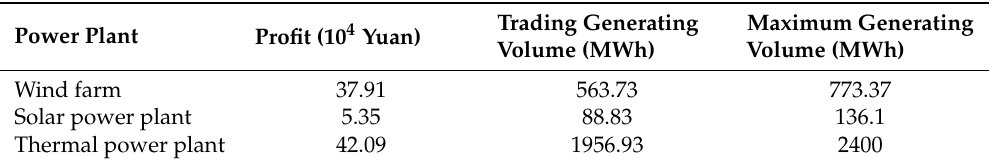
Figure 5. Power producers on the day-ahead market: ( a ) cleared generating volume; ( b ) profit. Table 4. Profit of power producers in the day-ahead market.